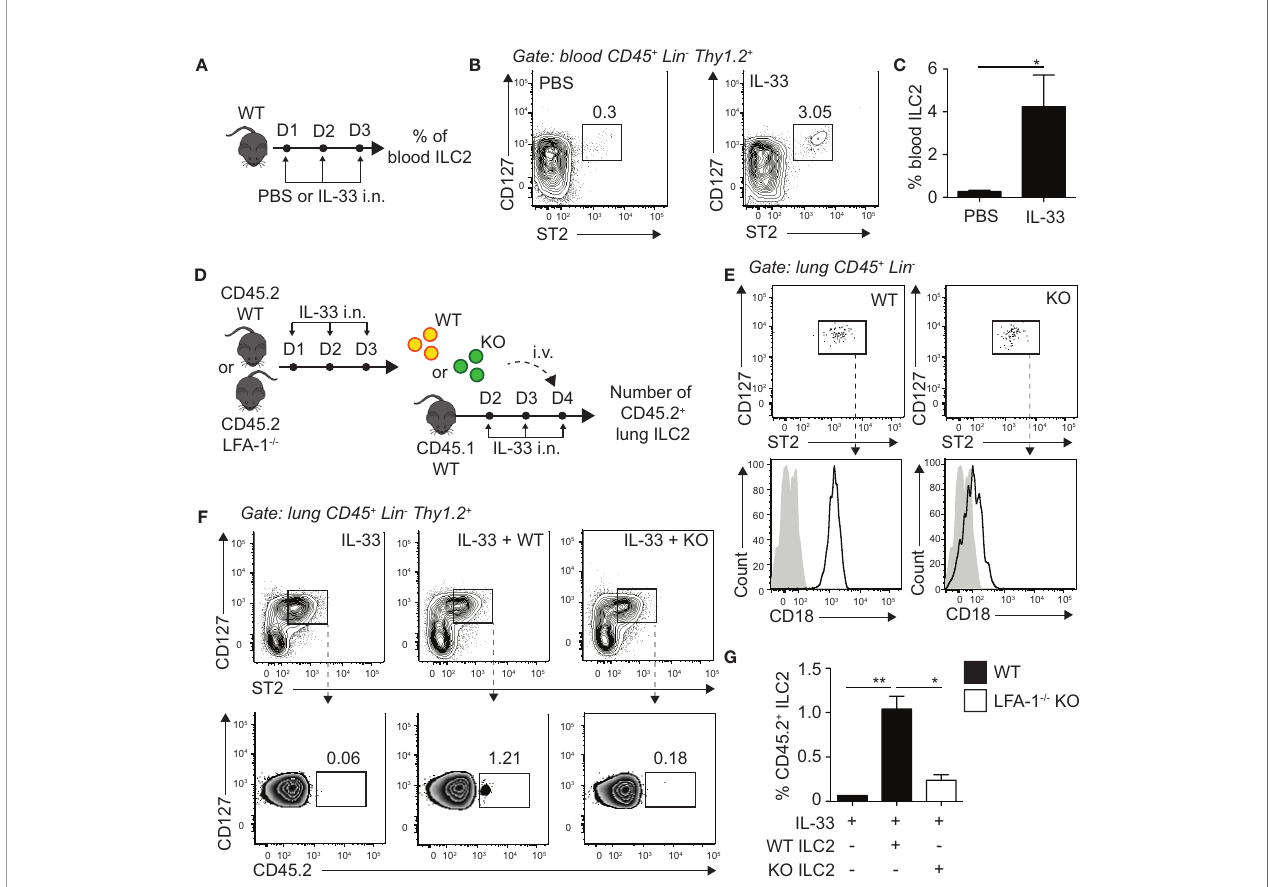
FIGURE 4 | LFA-1 on ILC2s controls ILC2 homing to the activated lungs. (A) C57BL/6 mice were challenged intranasally on days 1 to 3 with 0.5 µg rmIL-33 or PBS and on day 4 the frequency of CD45 + Lin − Thy1.2 + ST2 + CD127 + ILC2s in the peripheral blood was analyzed by fl ow cytometry. (B) Representative fl ow cytometry plots of peripheral blood ILC2s and (C) corresponding quantitation presented as the mean frequency ± SEM. (D) Cohorts of C57BL/6 (CD45.2) and LFA-1 − / − (CD45.2) mice were challenged intranasally on days 1, 2, and 3 with 0.5 µg rmIL-33. On day 4, lungs were recovered, processed to single cell suspensions and pulmonary activated ILC2s (aILC2)s were FACS-sorted to a purity of >95%. Concurrently, cohorts of C57BL/6 (CD45.1) host mice were challenged intranasally on days 2, 3 and 4 with 0.5 µg rmIL-33. On day 4, host mice were adoptively transferred with 10 × 10 3 FACS-sorted CD45.2 + aILC2 (WT or LFA-1 − / − ) by tail-vein injection in the corresponding cohorts. On day 5, lungs were recovered, processed to single cell suspensions and analyzed by fl ow cytometry for the presence of pulmonary CD45.2 + ILC2s. (E) Flow cytometry analysis of FACS-sorted pulmonary C57BL/6 and LFA-1 − / − ILC2s and corresponding expression of LFA-1 subunit CD18 prior tail-vein injection to host mice. (F) Representative fl ow cytometry plots of total pulmonary ILC2s in the corresponding cohorts (upper) and frequencies of CD45.2 + adoptively transferred ILC2s within each population (lower). (G) Corresponding quantitation presented as the mean frequencies of CD45.2 + within total lung ILC2s ± SEM. Data are representative of 3 individual experiments with n = 5 – 10. *p < 0.05, **p <